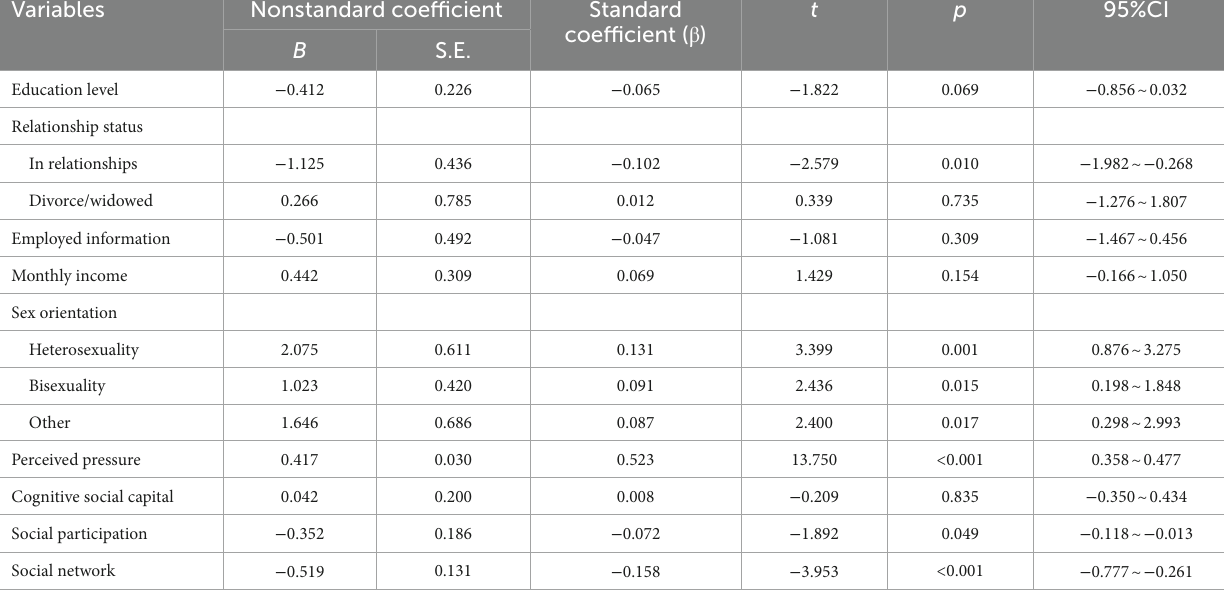
TABLE 2 Factors associated with MSM mental health based on multiple linear regression analysis ( n = 546).